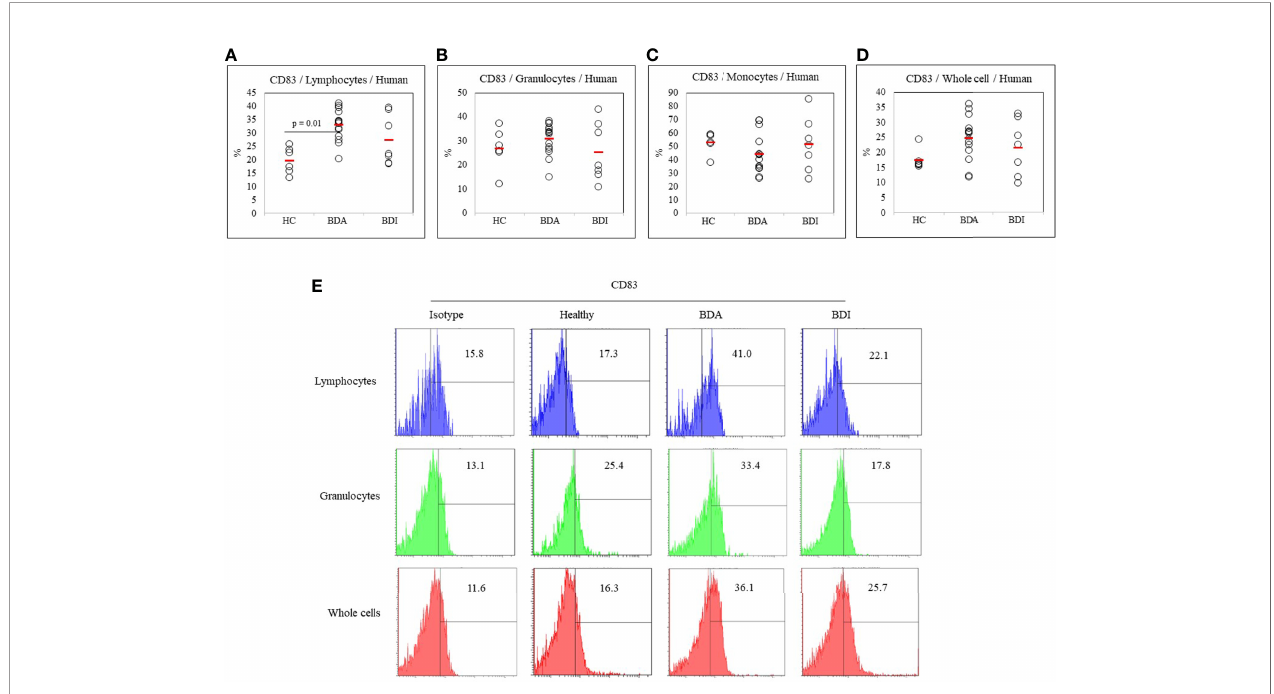
FIGURE 2 | Frequency of CD83+ cells in peripheral blood leukocytes (PBL), lymphocytes, granulocytes, monocytes, and whole cells (A – D) of healthy controls (HC), patients with active Behc ̧ et ’ s disease (BDA), and patients with inactive Behc ̧ et ’ s disease (BDI). The isolated peripheral blood leukocytes (PBL) were subjected to surface staining and analyzed by fl ow cytometry. The results were obtained from six HC, fourteen BDA patients, and seven BDI patients. Statistical analysis was performed by the Kruskal-Wallis test. Representative FACS histograms of peripheral blood lymphocytes, granulocytes, and whole cells are shown in (E)